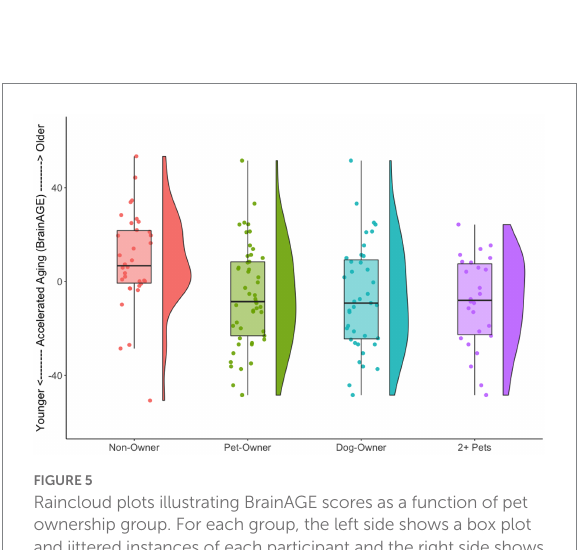
FIGURE 5 Raincloud plots illustrating BrainAGE scores as a function of pet